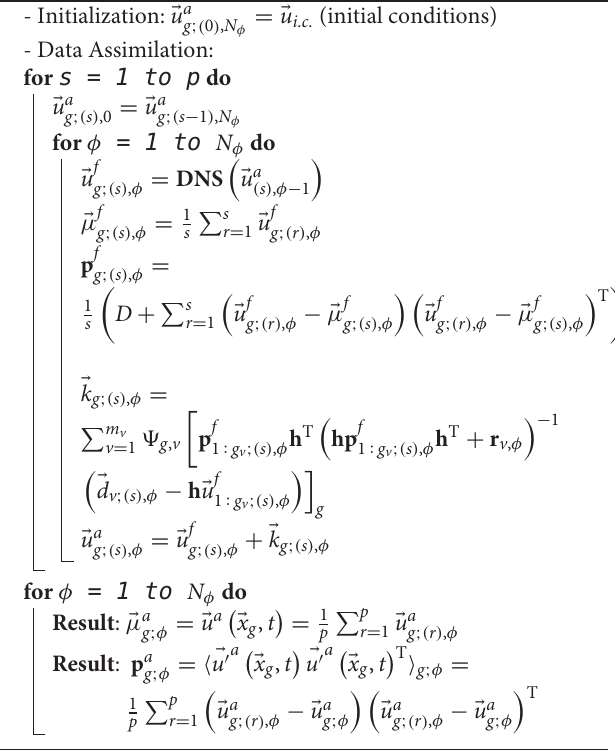
Algorithm 1: Data Assimilation algorithm for computing enhanced volex-based